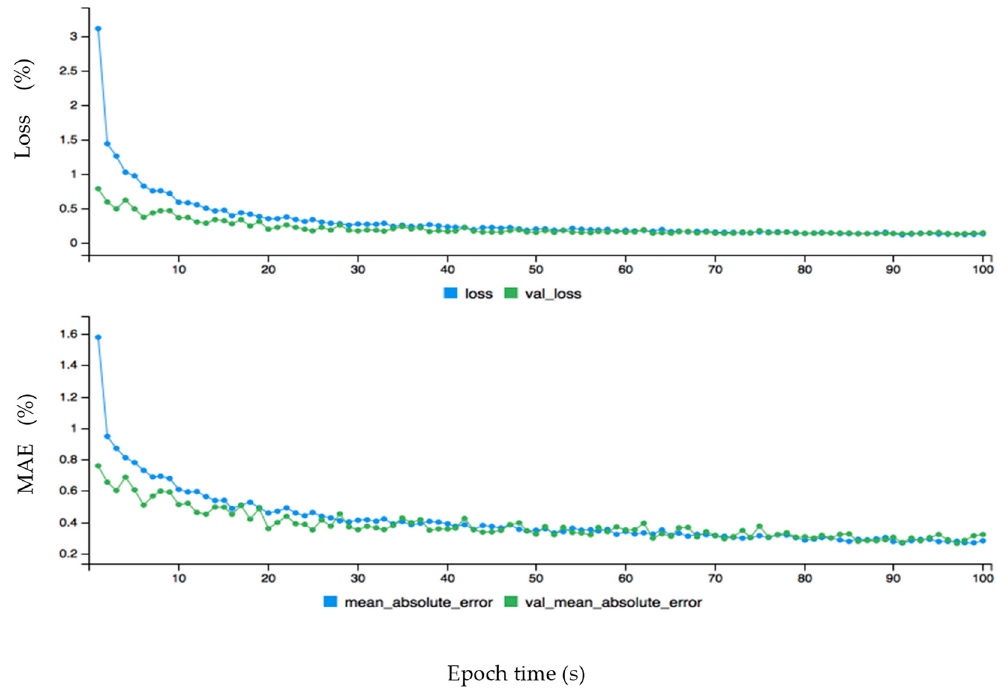
Figure 10. The dynamic plot of forecasting error after fine tuning configuration for hourly wind data.